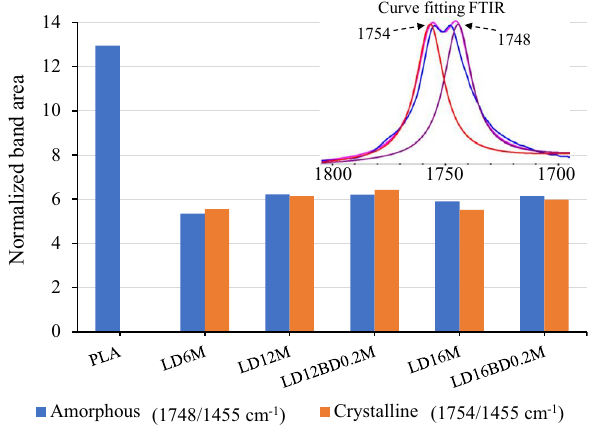
Figure 5. Normalize band areas of the amorphous (1748/1455 cm -1 ) and crystalline (1754/1455 cm −1 ) C = O characteristics of lactate sequences obtained from FTIR curve fitting